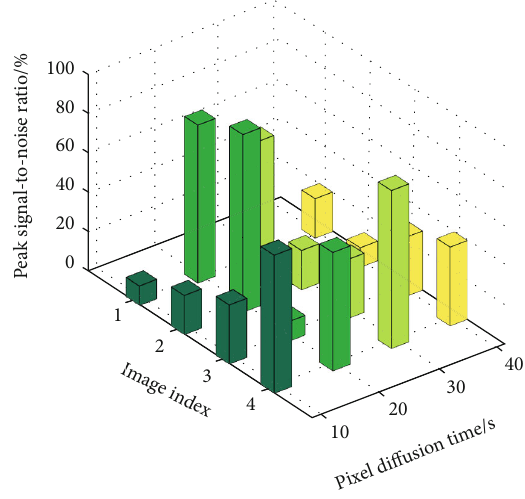
Figure 9: Three-dimensional histogram of peak signal-to-noise ratio with pixel di ff usion time.